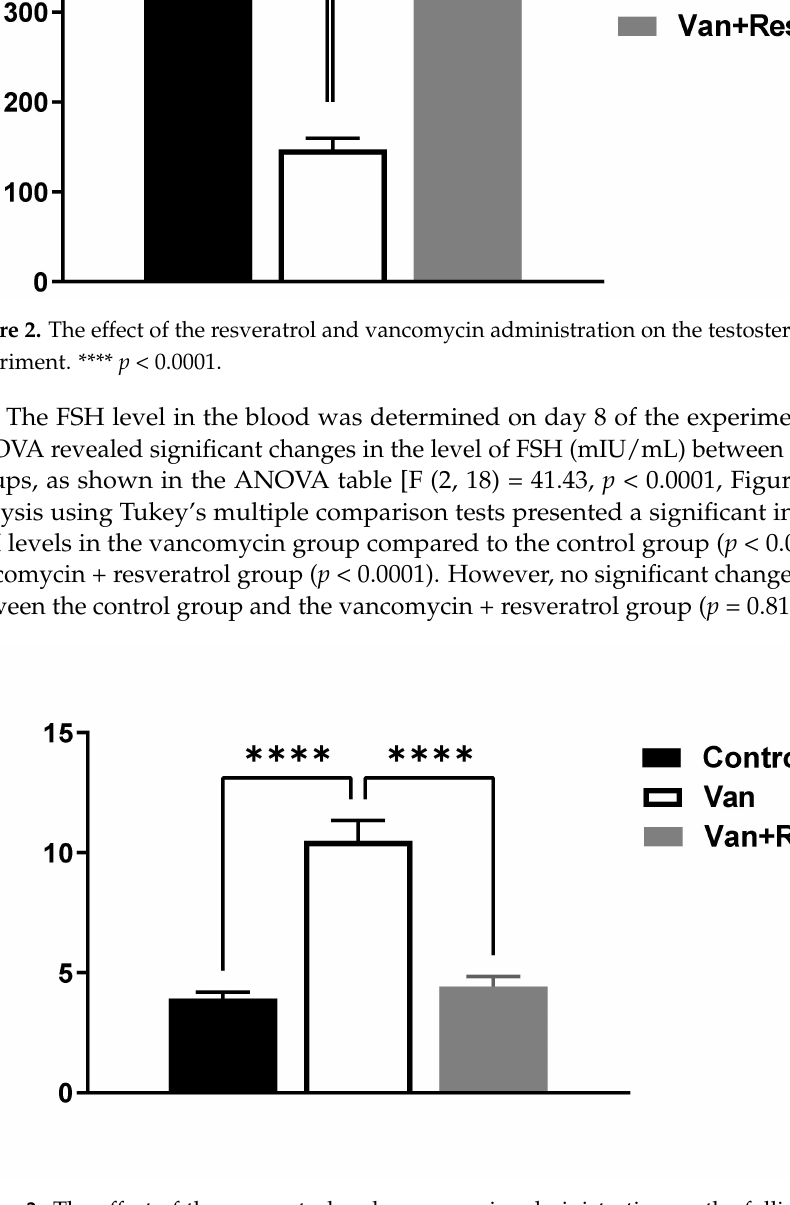
Figure 3. The effect of the resveratrol and vancomycin administration on the follicle-stimulating hormone during the experiment. **** p <